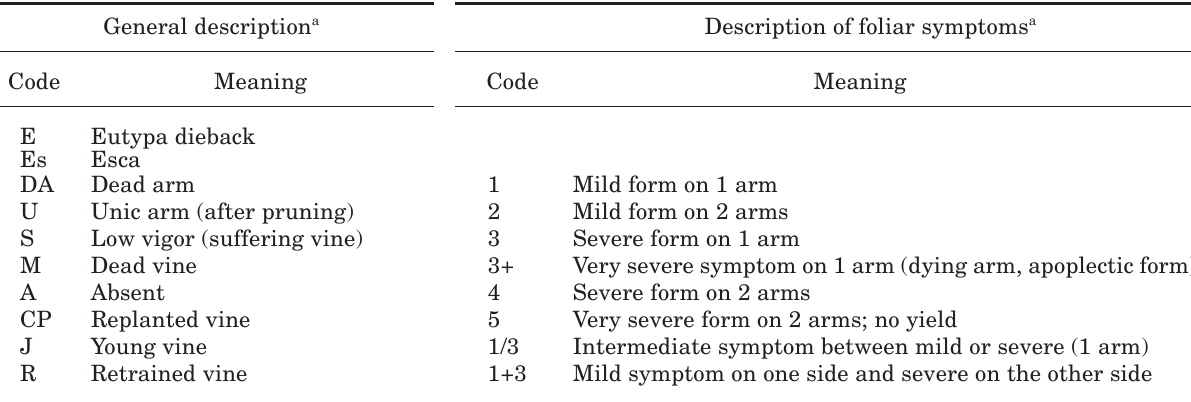
Table 2. Ranking index used for assessing the occurrence and severity of symptoms a associated with grapevine decline.